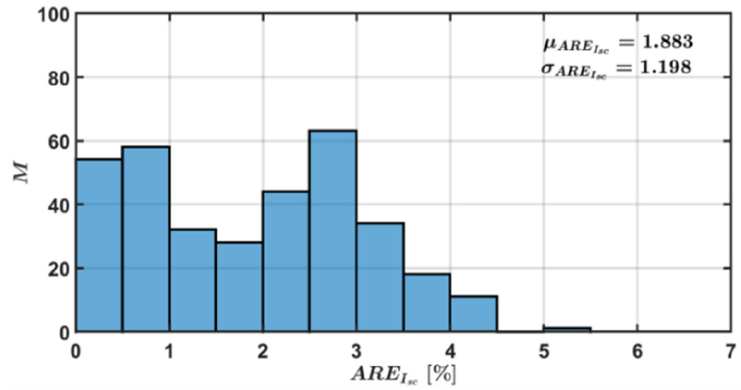
Figure 21 . Histograms of the errors .